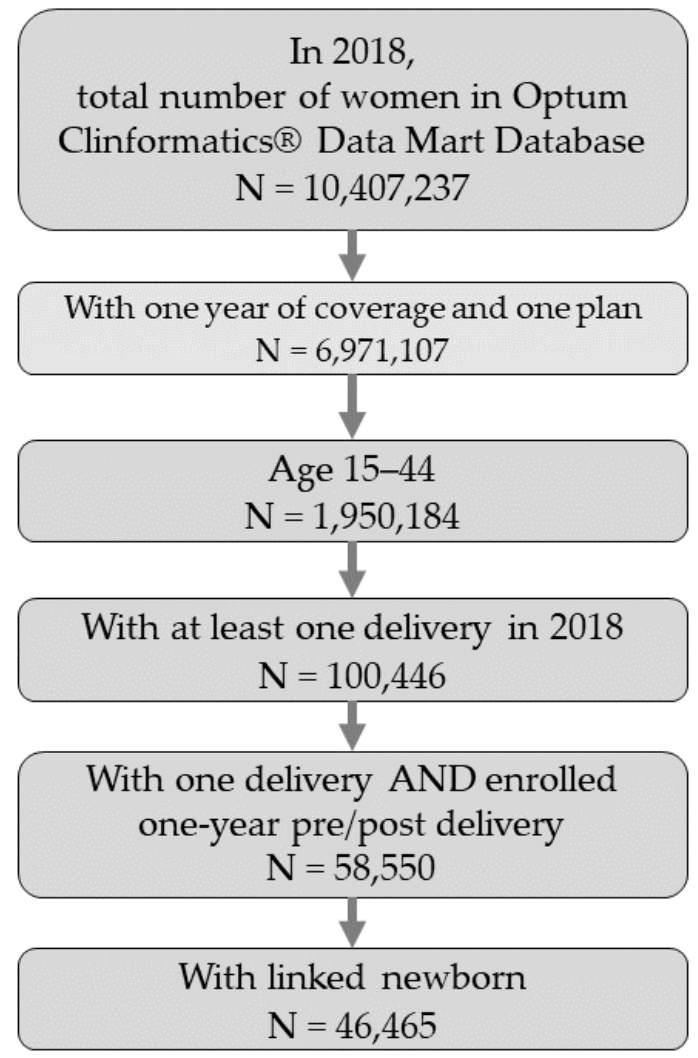
Figure 1. Cohort construction flowchart of inclusion and exclusion criteria, using 2018 as an exam- ple.